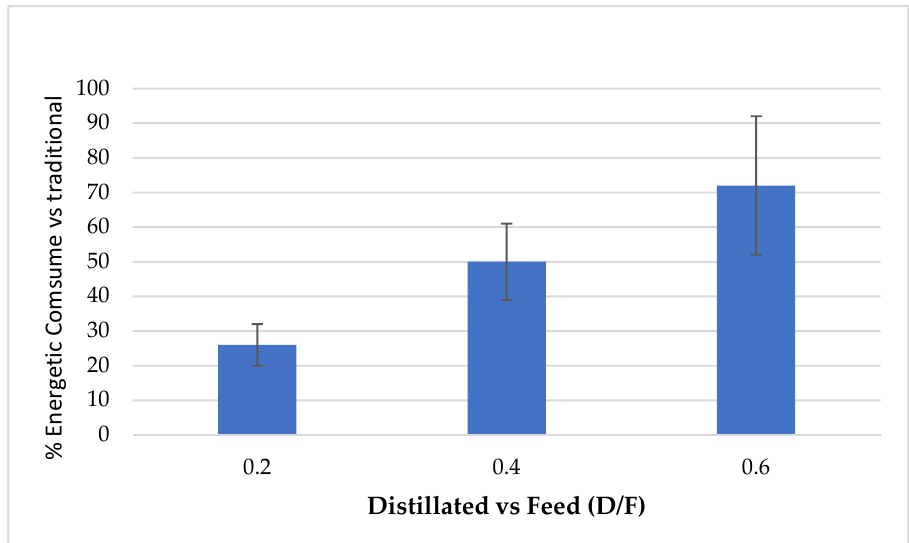
Figure 4. Percentage of steam consumption in continuous vs. traditional processes.